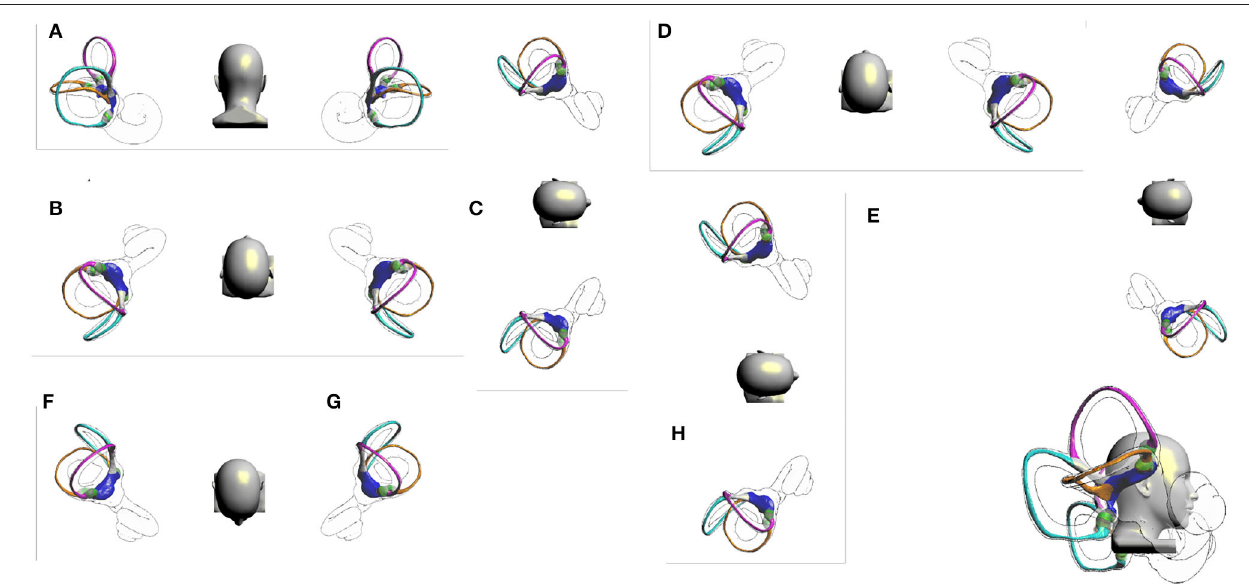
FIGURE 2 | Right Barbecue maneuver. (A) Upright position. (B) Rapidly laid back to the supine position. (C) Turn over 90 ◦ to the right, right lateral position. (D) Turn over 90 ◦ to the left, supine position. (E) Continue turning over 90 ◦ , left lateral position. (F) Continue turning over 90 ◦ , prone position. (G) Continue turning over 90 ◦ , left lateral position. (H) Sit up sideways and return to an upright position.